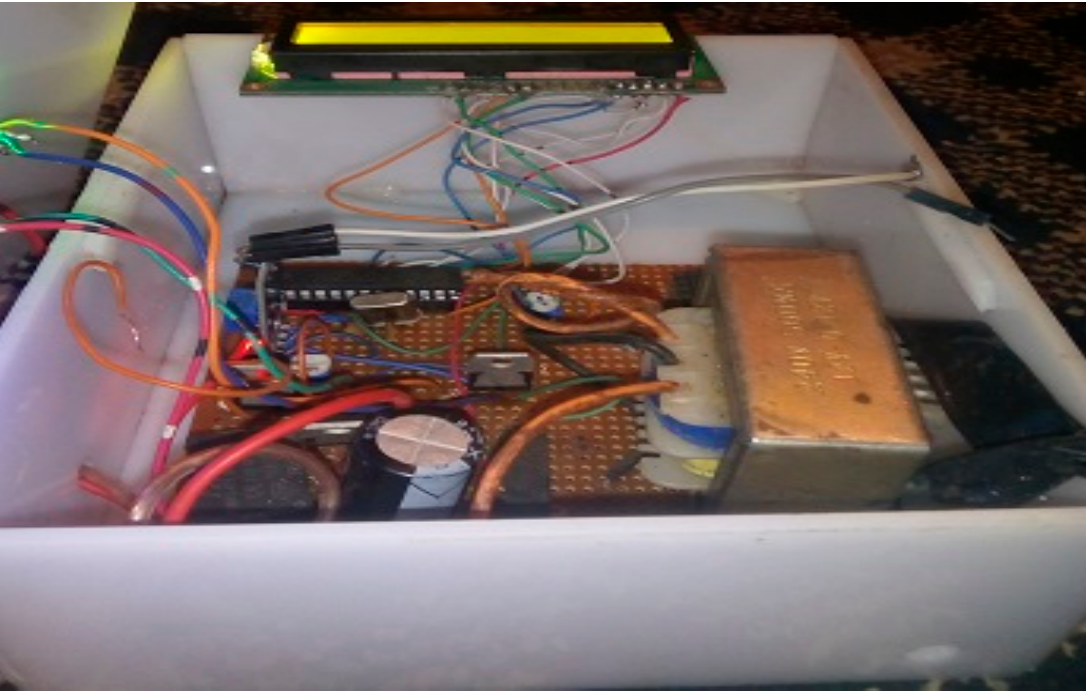
Figure 11. The implemented prototype view part 1.